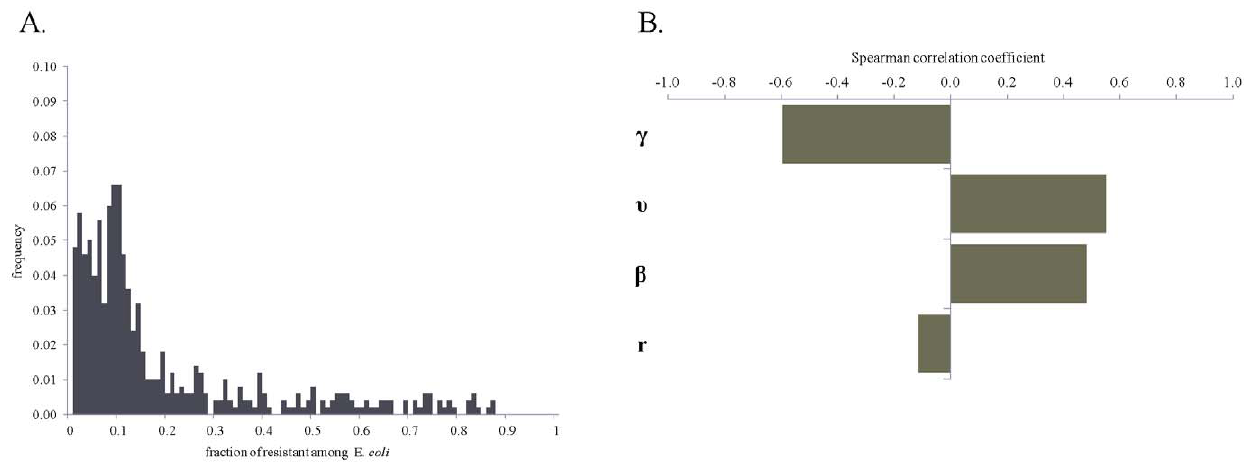
Figure 5. Fraction of ceftiofur-resistant among enteric E.coli in long-term absence of ceftiofur pressure. A: Uncertainty: frequency histogram for 500 model simulations with randomly varying parameters of bacterial ecology. B: Sensitivity: significant linear correlations ( p -value # 0.05) between ranked-transformed values of the parameters of bacterial ecology and the fraction of resistance.